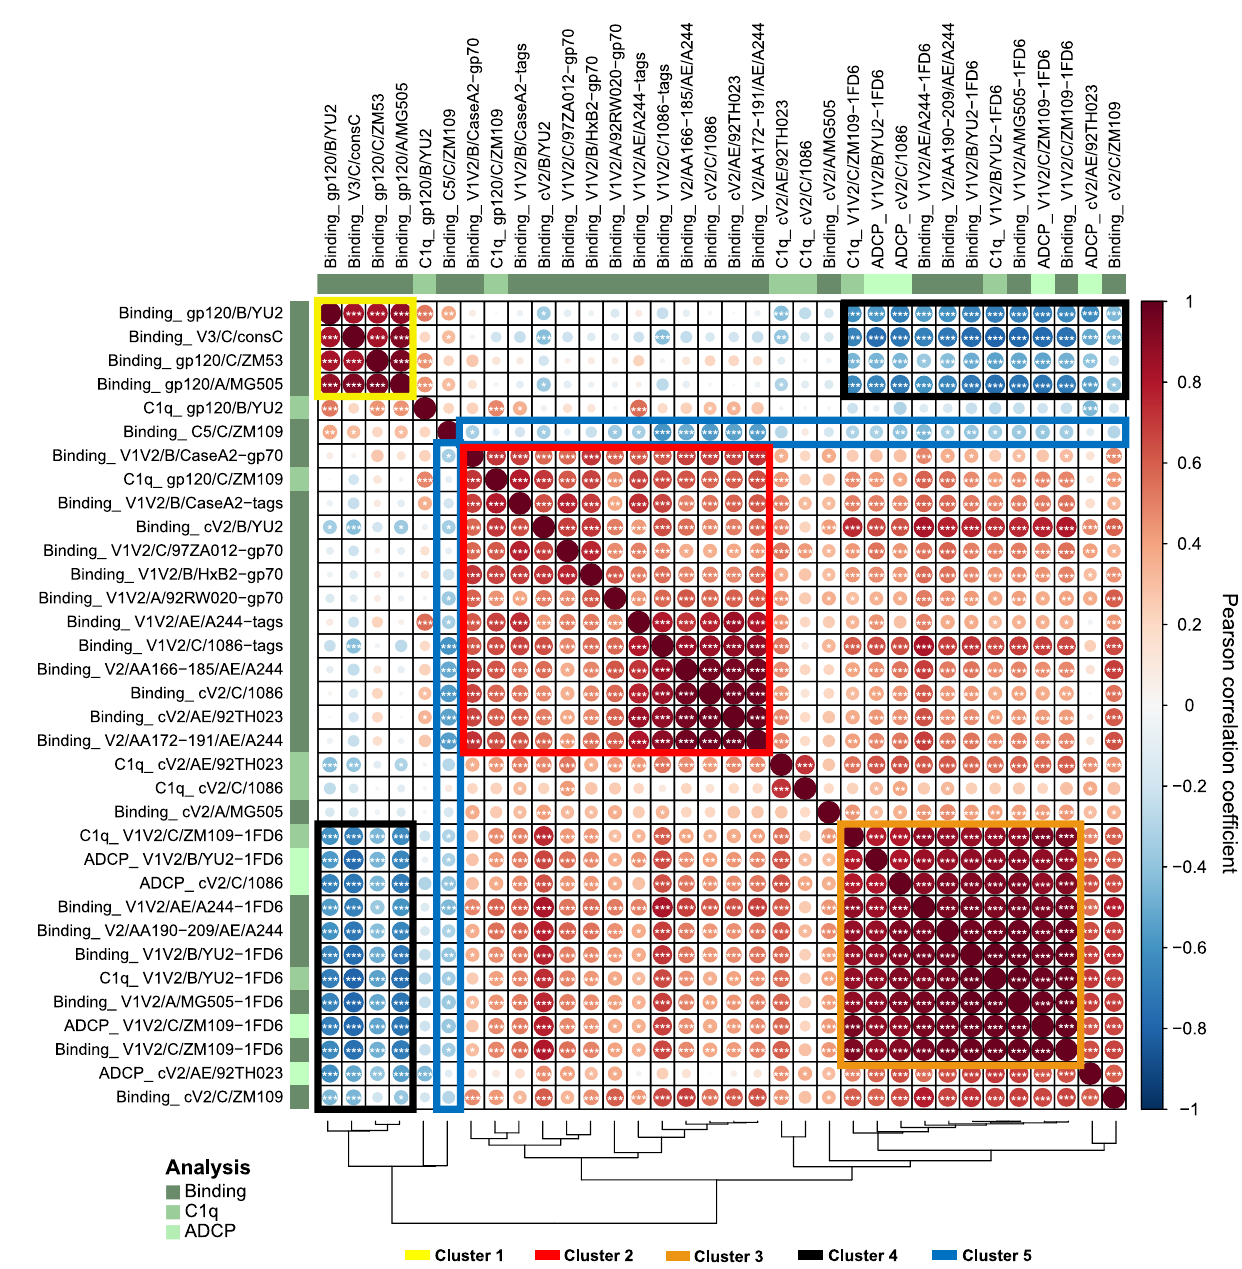
Fig. 6 Correlation analysis of Ab binding, C1q binding, and ADCP against various HIV-1 Env antigens. Correlogram summarizing pairwise correlations among indicated parameters for all 45 studied NHPs. In the correlogram, the magnitude of the correlation coef fi cient r is color-coded as per the spectrum shown on the right with red colors representing positive and blue colors negative correlations between any two parameters. Asterisks within each cell indicate statistically signi fi cant correlations (* p < 0.05, ** p < 0.001, *** p < 0.005; two-tailed p values from Pearson correlation). The correlogram is shown with hierarchical clustering according to the dendrogram at the bottom. The fi ve most prominent correlation clusters are highlighted with boxes and numbered as indicated in the legend. Source data are provided as a Source Data fi